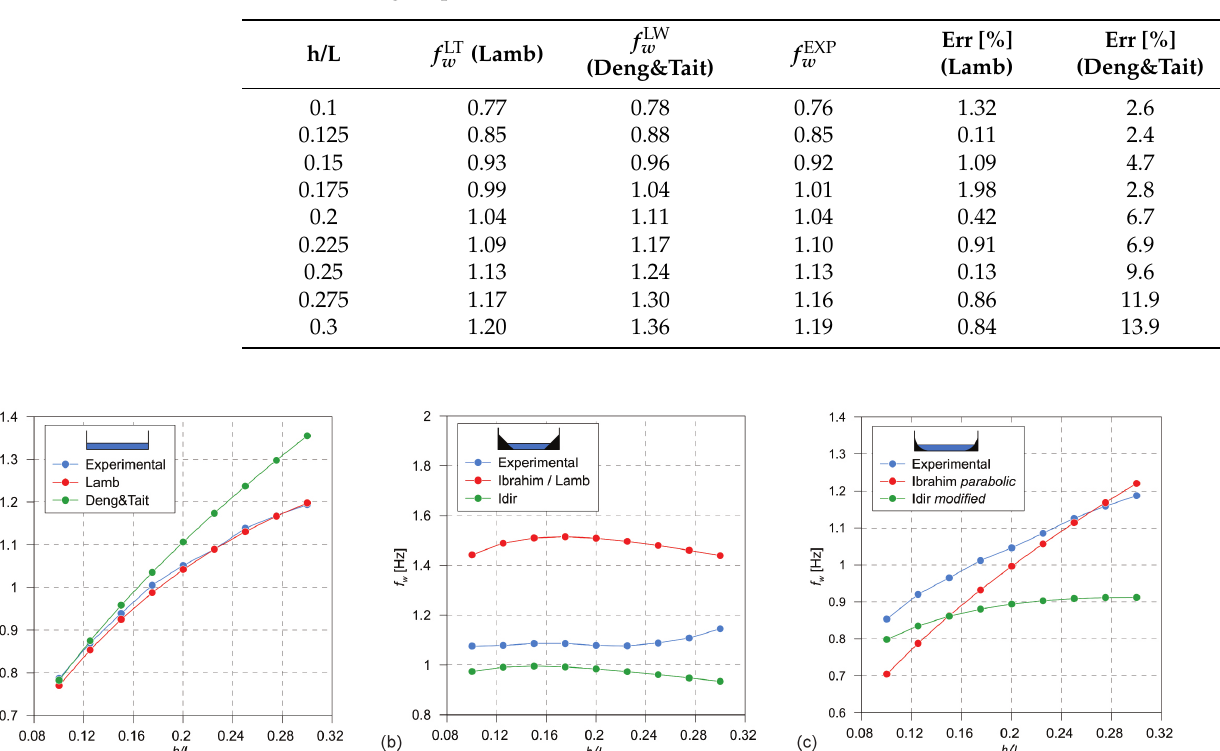
Table 1. Comparison between analytical (Lamb and Deng and Tait formulations) and experimental natural sloshing frequencies obtained with the flat bottom tank.